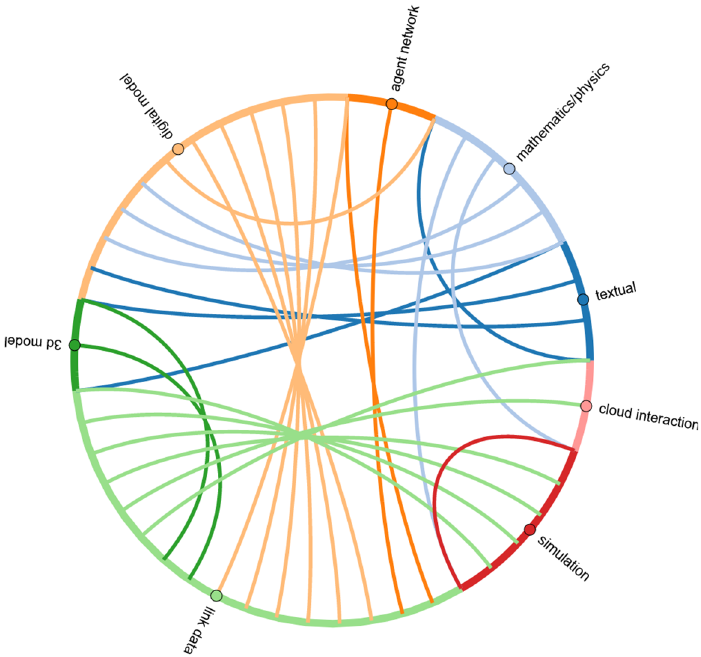
Figure 4. Chord diagram showing the different stages and the links between.